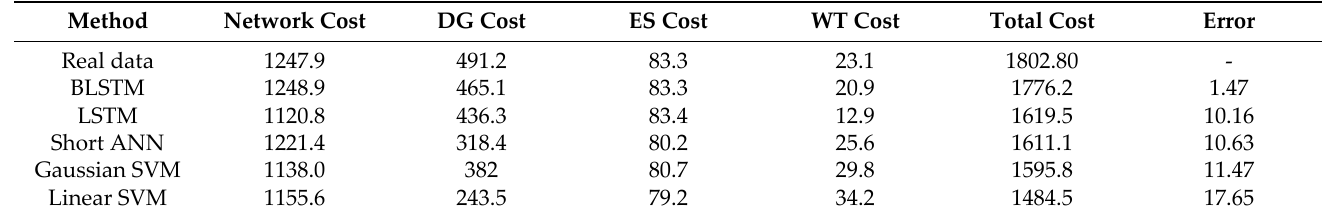
Table 8. VPP costs in different